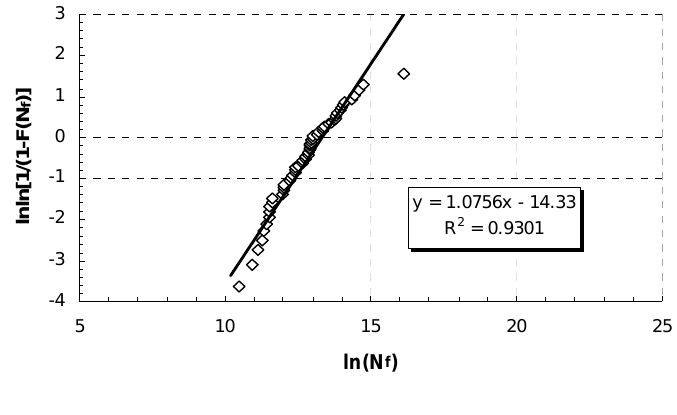
Figure 15. The two-parameter Weibull model